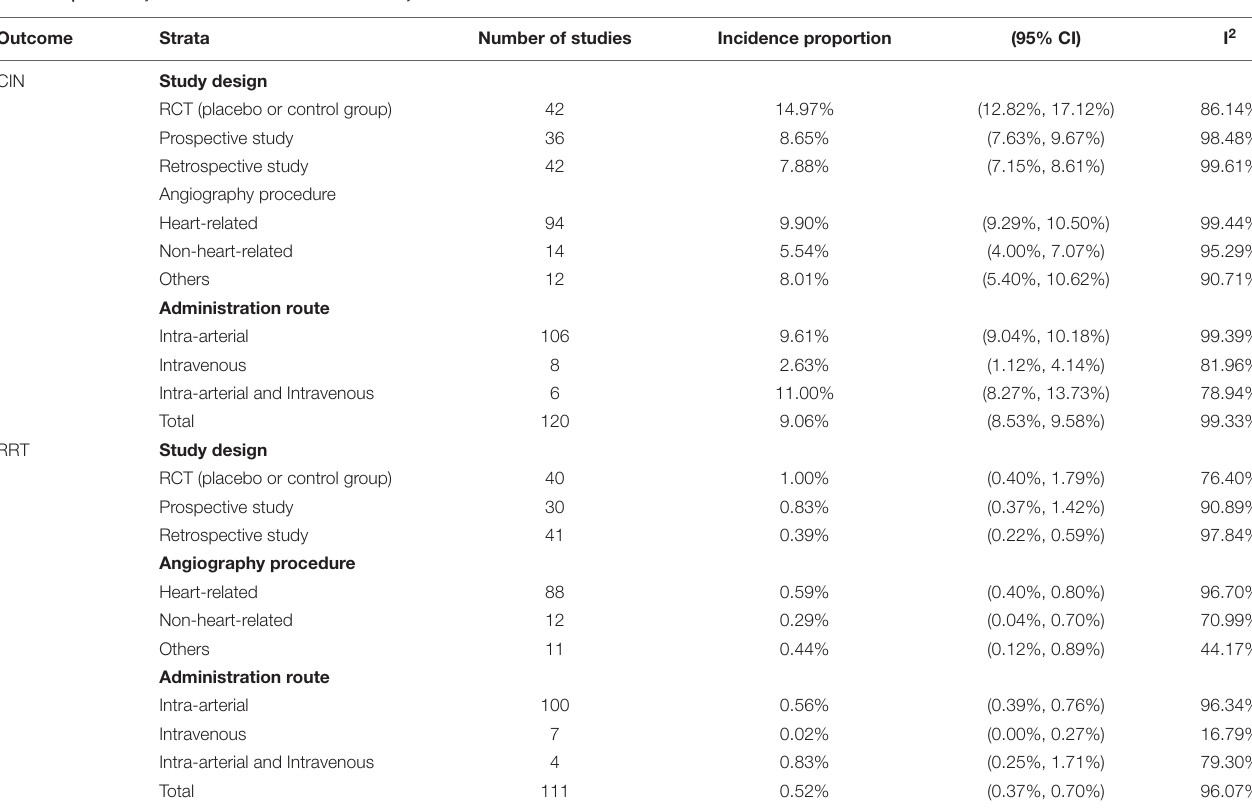
FIGURE 1 | Flow diagram of articles considered for inclusion. TABLE 1 | Summary of overall and stratified meta-analysis